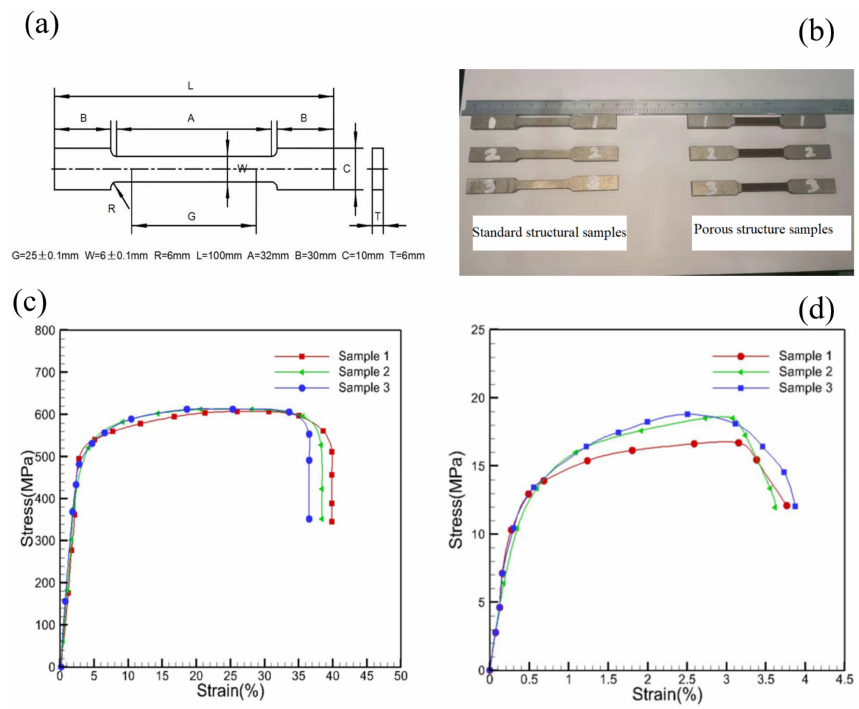
Figure 15. Tensile property test of samples (( a ) structure of test sample; ( b ) printed tensile samples; ( c ) tensile test results of standard structural samples; ( d ) tensile test results of porous structure